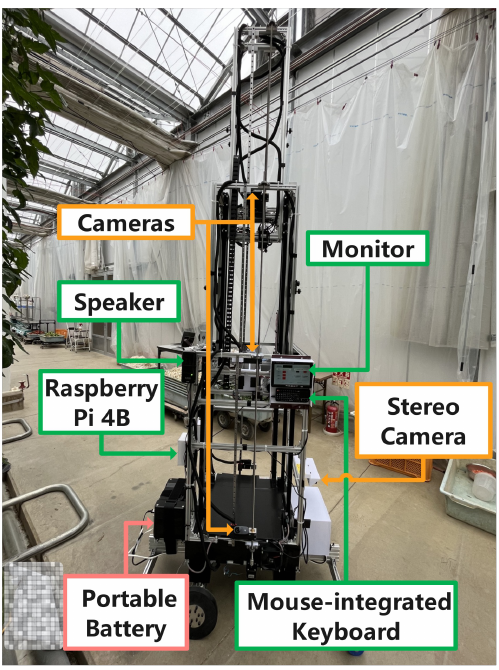
Figure 7. Devices that need to be highlighted.